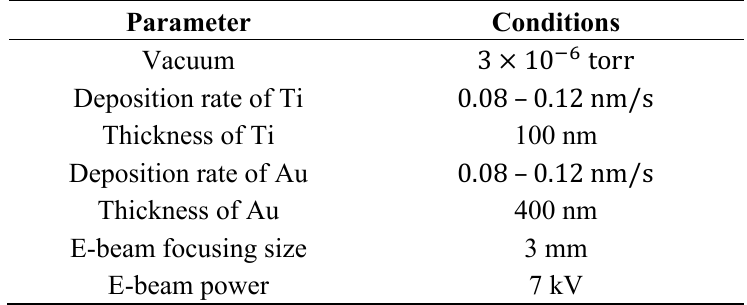
Table 1. Deposition conditions of metal layers (Ti and Au) on the PDMS surface.